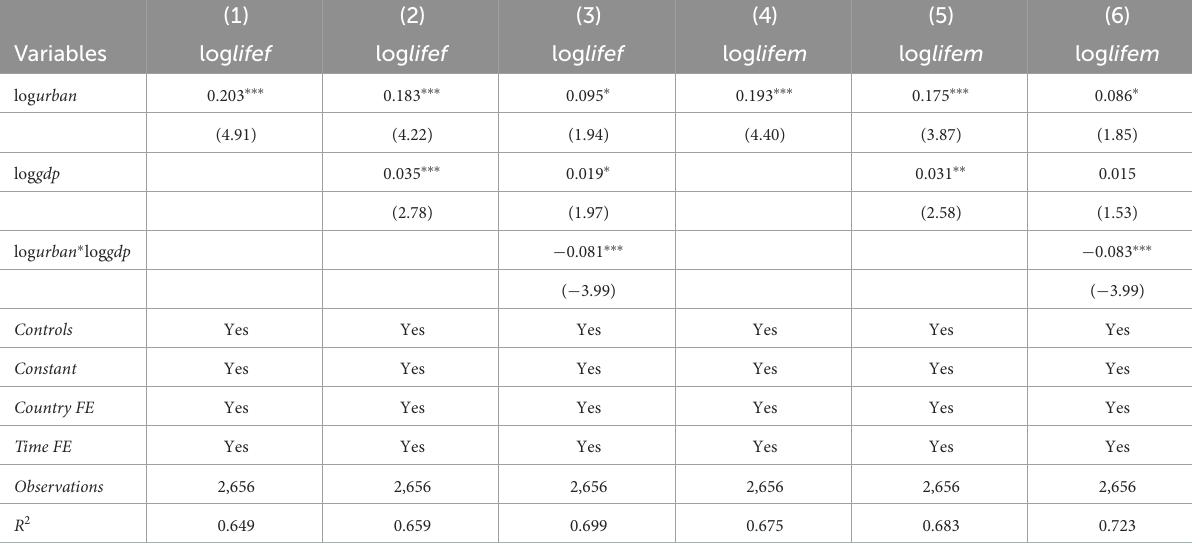
TABLE 11 Test results of potential channel mechanism (female and male life